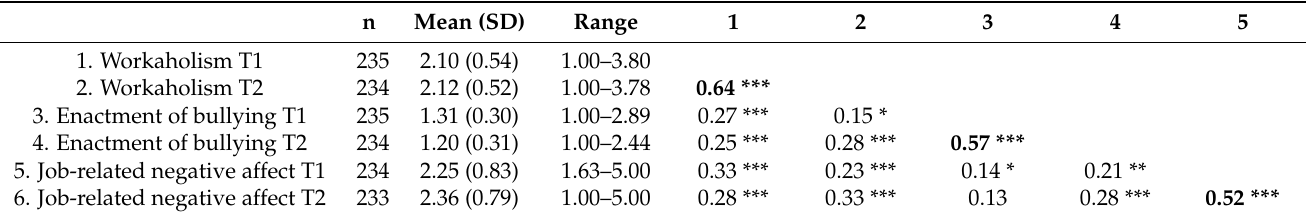
Table 1. Descriptive statistics and zero-order Pearson correlation coefficients between the study